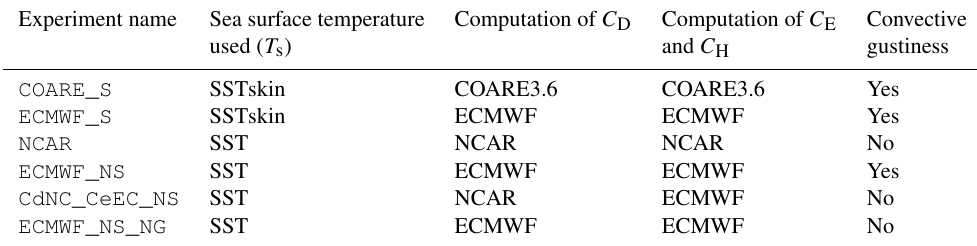
Table 1. Summary of the numerical